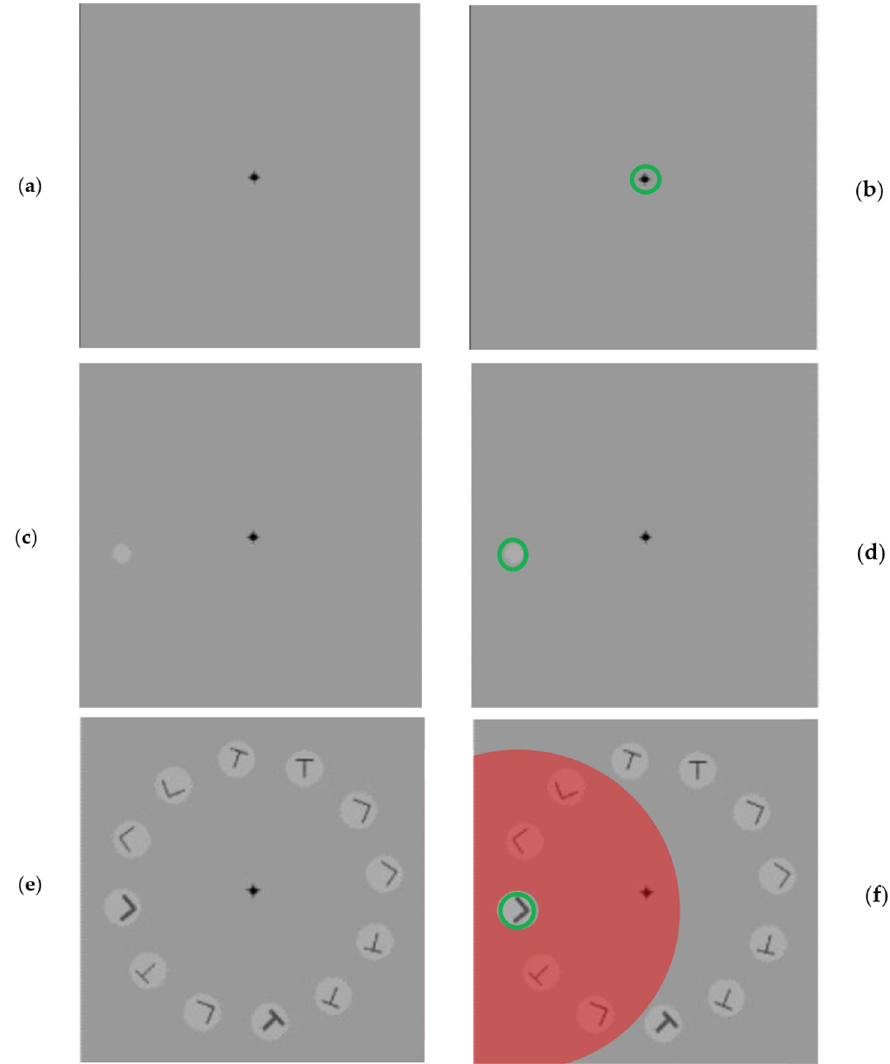
Figure 3. The attentional selections in the experiment of Cutzu and Tsotsos [25]. The left panel of figures show the sequence of displays presented to a subject. The right panel shows the attentional operation, with green indicating selection and red indicating suppression. ( a ) The first display gives the point to which subjects are instructed to fixate. ( b ) Shows that, in order to fixate, one must first attend that location (one-of-many). ( c ) The display gives the subject the cue to which to attend, while maintaining fixation. The cue is a region and thus a some-of-many selection is applied. ( d ) Shows the cue selection. ( e ) The test display with target and probe in bold. ( f ) Attending the cue location imposes a top-down suppressive surround shown in red; a none-of-many selection applied together with the some-of-many selection for the cue (while still fixating, of course) (adapted from [25]). A second example shows that selection operations span layers of a network. Earlier,